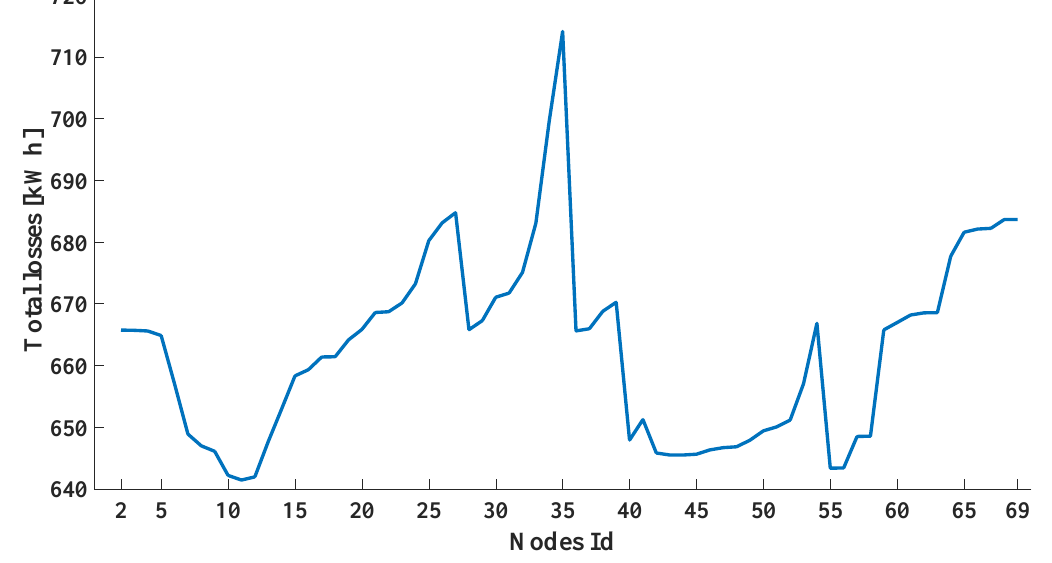
Figure 4. Monthly energy losses for different positioning of the battery energy storage system